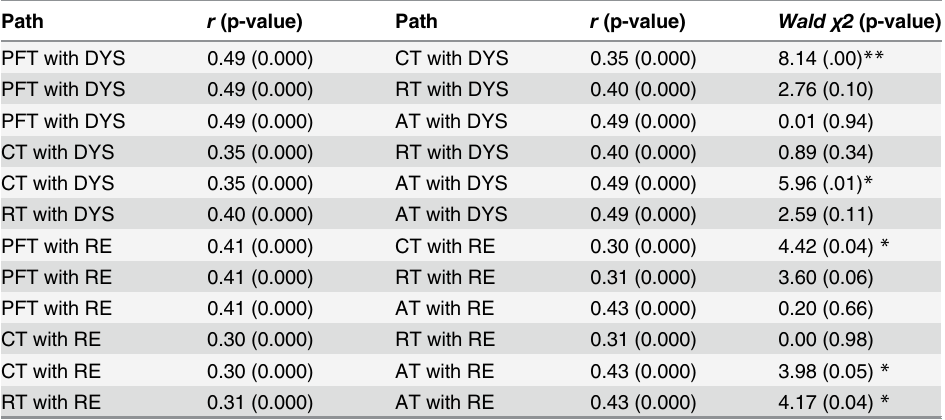
Table 7. Correlations between the Four-Factor Rumination Model and PTSD ’ s Dysphoria Factor, and the Corresponding Wald Test Values.